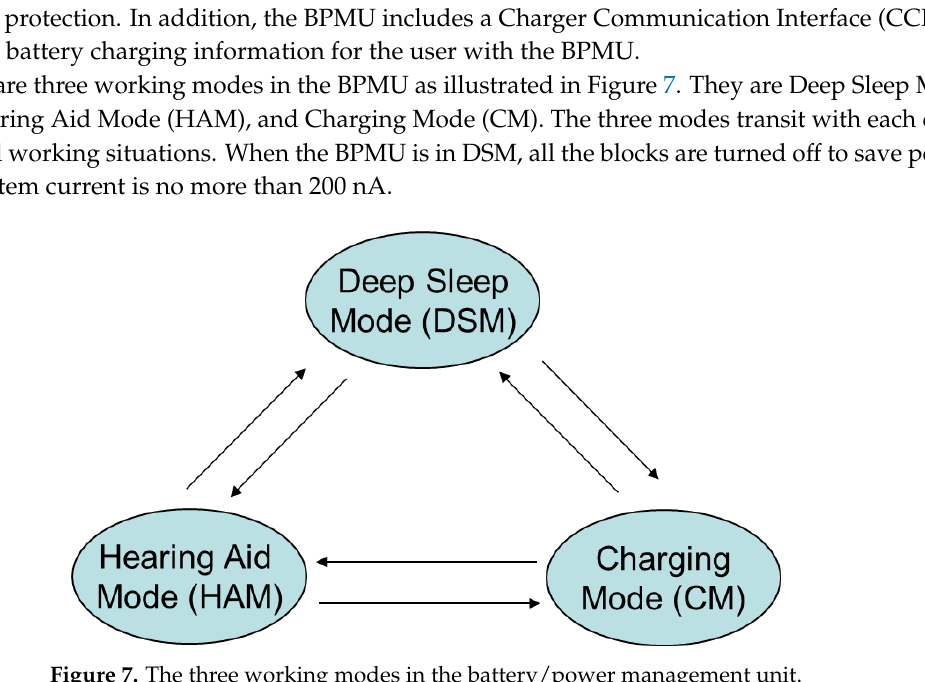
Figure 7. The three working modes in the battery/power management